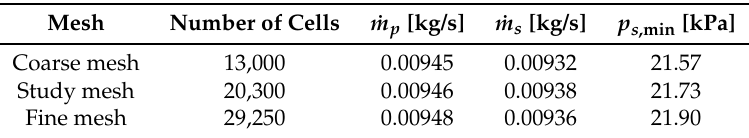
Table 2. Data for grid convergence